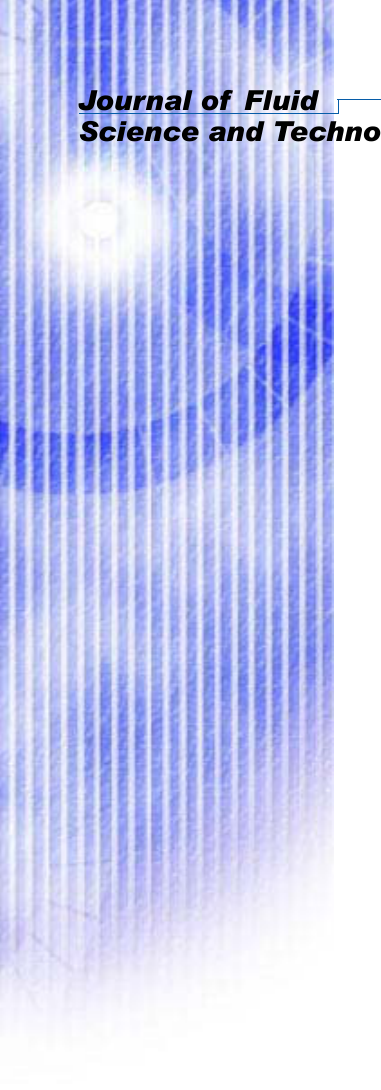
(19) . For Q = 0.00, there are two peaks on both sides of the separating shear layer. The